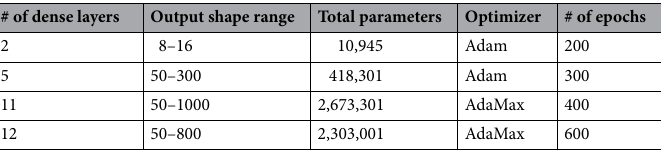
Table 2. Various deep neural network settings under which MLP and transfer learning were experimented